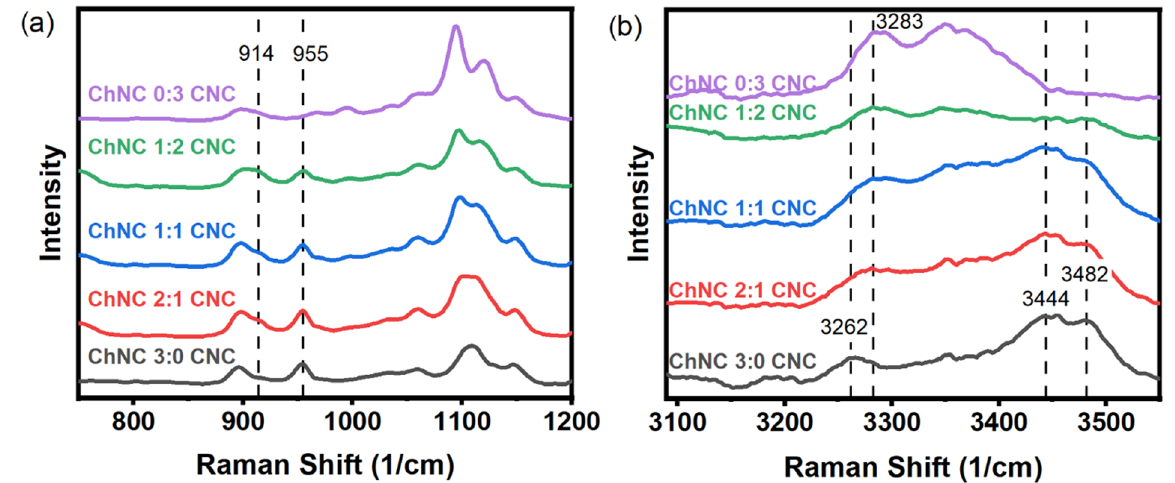
Figure 2. Raman spectra of ChNC, CNC, and ChNC-CNC nanoconjugates from ( a ) 750 to 1200 cm − 1 , and ( b ) 3100 to 3550 cm − 1 . In ( a ), evidence of a sulfate-ammonium interaction is observed by the shoulder at 914 cm − 1 and the peak at 955 cm − 1 . Panel ( b ) shows an alteration of the hydrogen bond pattern as the ChNCs and CNCs are mixed together in addition to the presence of -NH stretching bands at 3444 and 3482 cm − 1 for chitin that are not present in CNC.